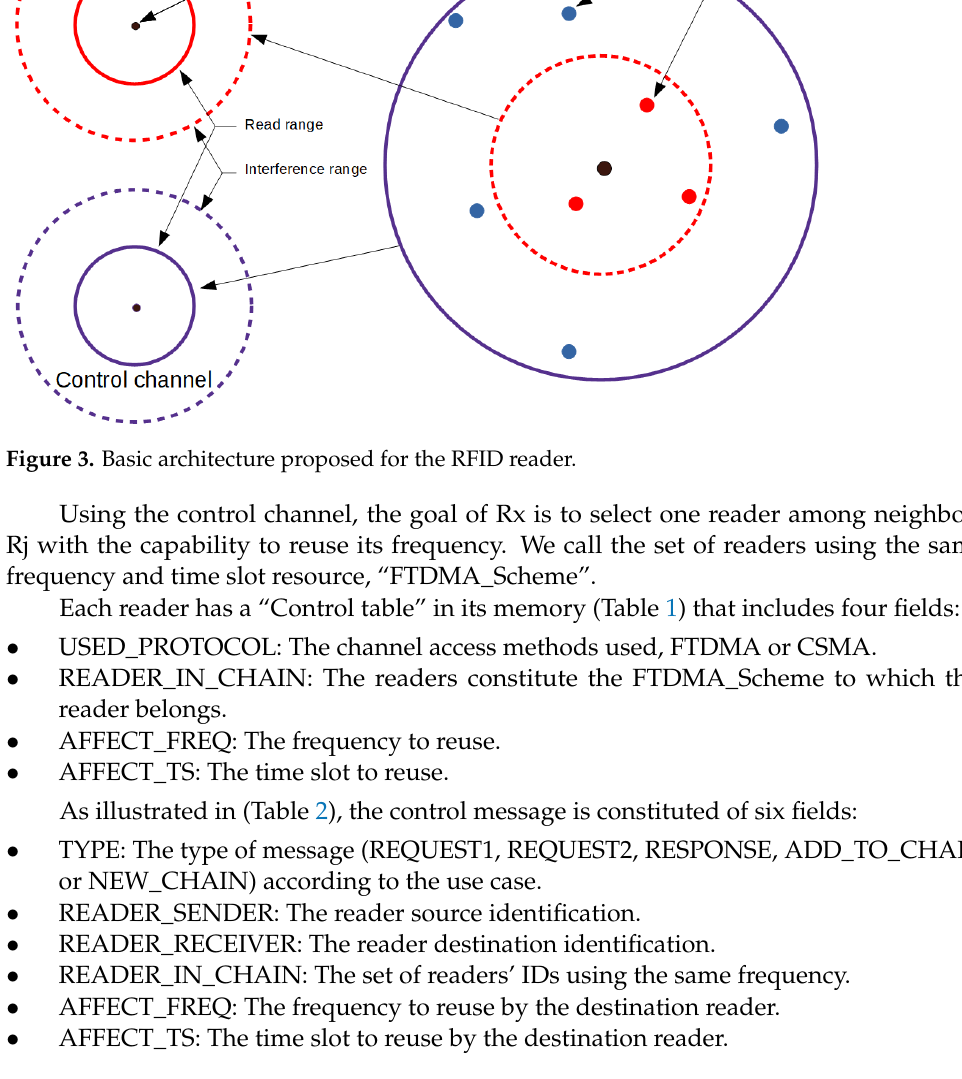
Table 2. Proposed control message structure.